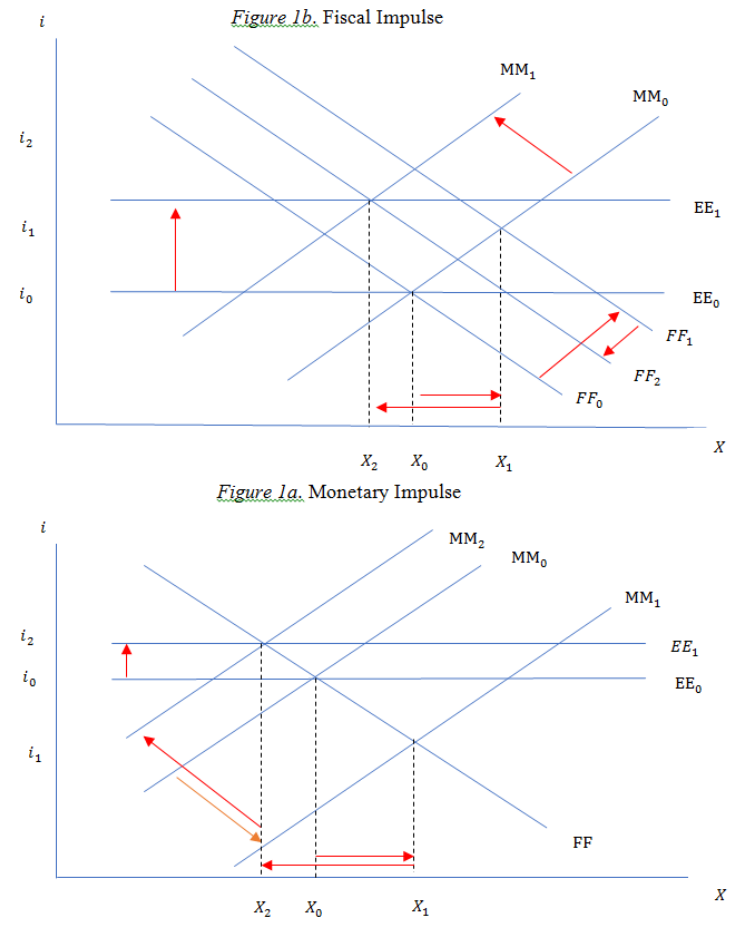
. Fig. 1a portrays the case where the expansionary